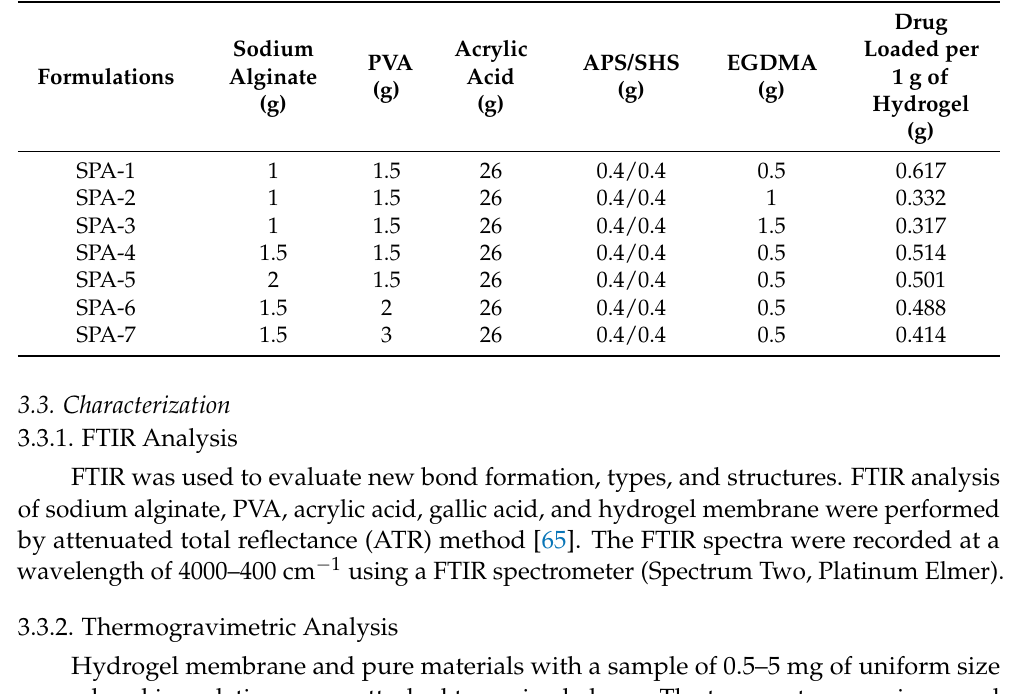
Table 3. Hydrogel membrane feeding composition per 100